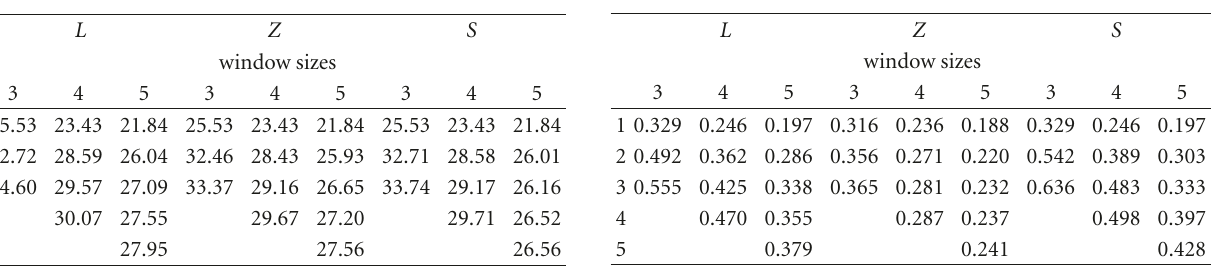
Table 3: Compression ratio for one-dimensional FMP.